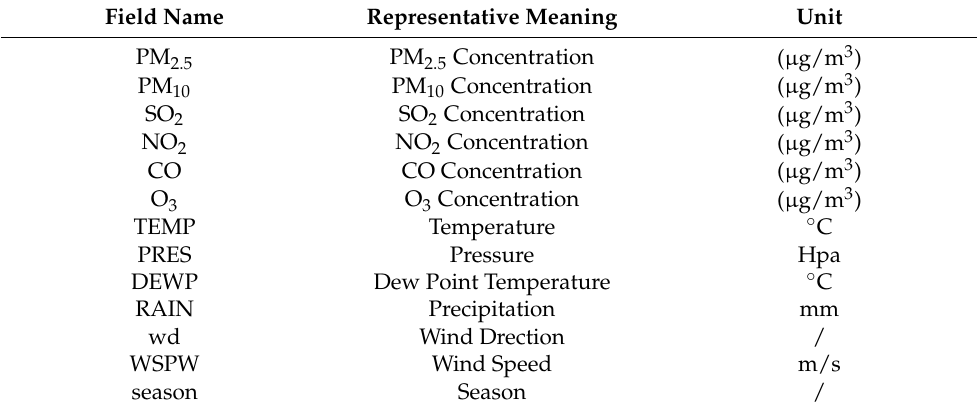
Table 3. The meanings of data